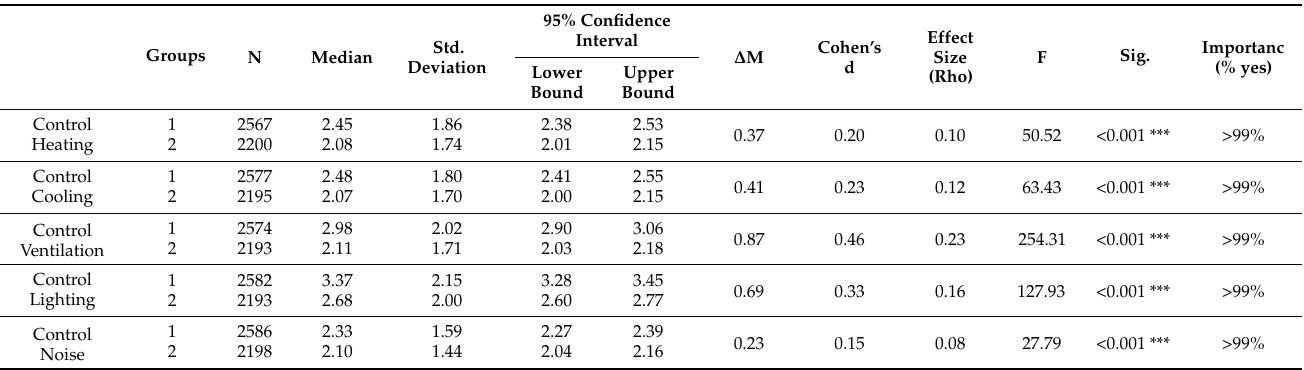
Table 6. Mean differences and effect size calculation comparing green and non-certified buildings regarding control parameters.